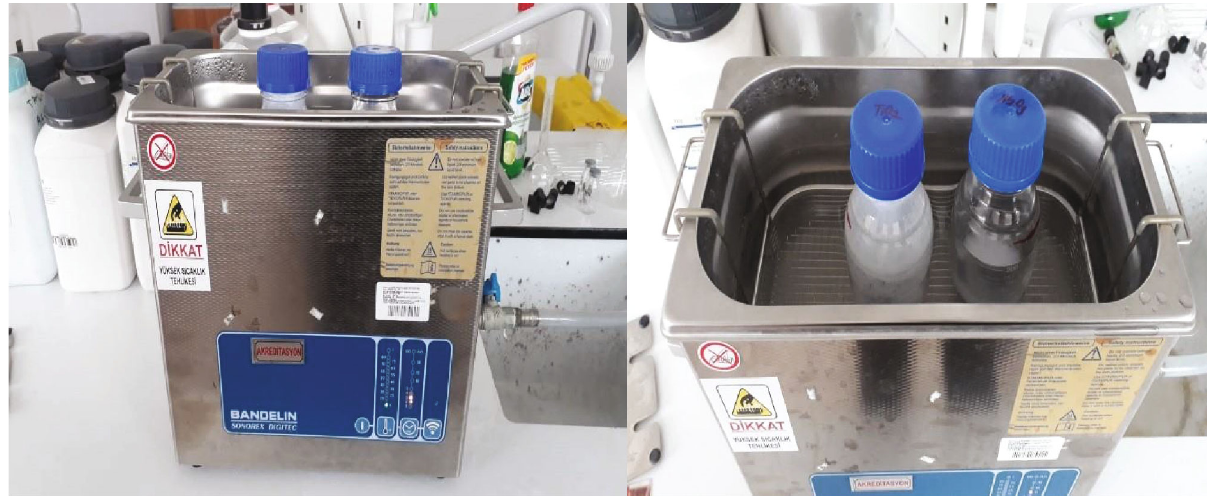
Figure 1: Ultrasonic bath setup.